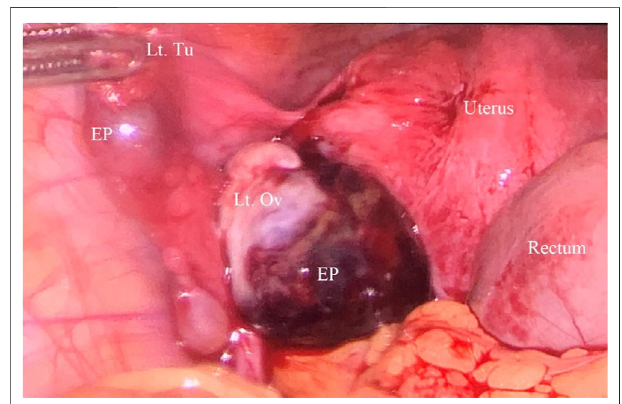
FIGURE2| Laparoscopicviewofunrupturedleftovarianpregnancyand ipsilateraltubal pregnancy (Lt.Tu=LeftFallopiantube, Lt. Ov=LeftOvary,EP = ectopic